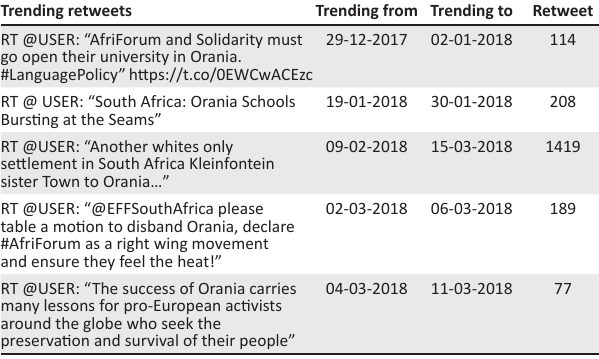
TABLE 4: Tweets that were retweeted the most. TABLE 3: Political or news events.